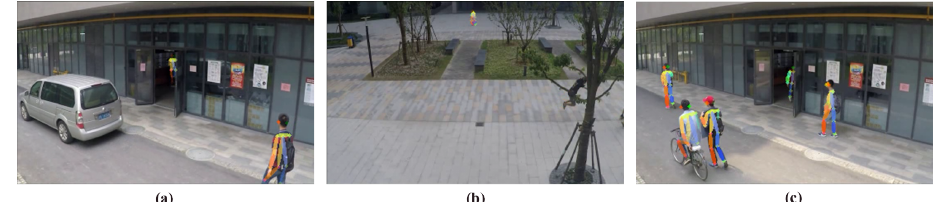
Figure 9. The failure cases on the ShanghaiTech Campus dataset. ( a ) Vehicle appears in the clip, which is not processed by our method; ( b ) Abnormal motion tracking skeleton may be lost when obstructed by obstacles; ( c ) False negative situation is a misjudgment by a slow